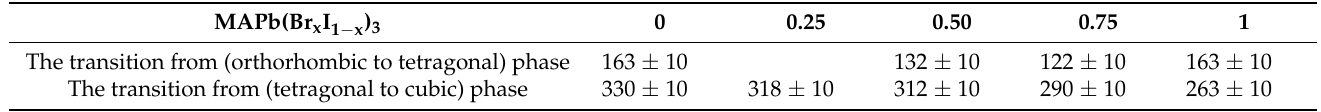
Table 4. The transition point with the temperature of MAPb(Br x ,I 1 − x ) 3 perovskite